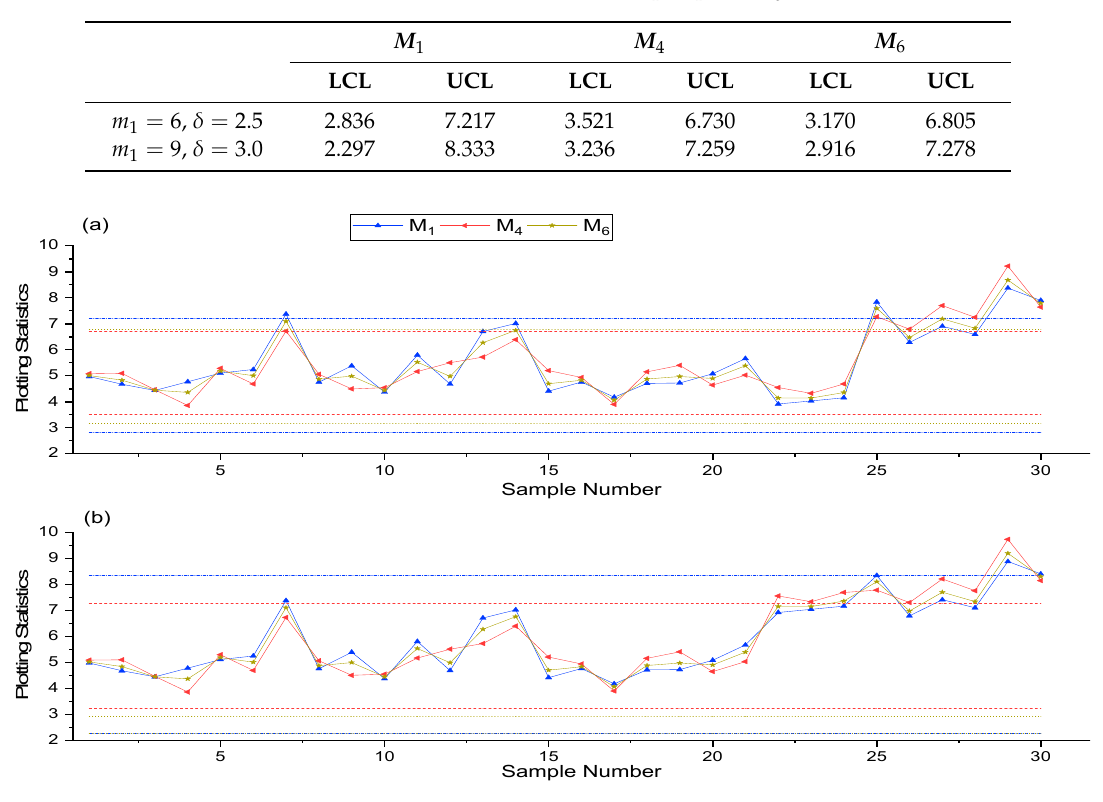
Figure 9. Graphical displays of plotting statistics corresponding to their control limits at ( a ) 𝑚 = 6 and 𝛿 = 2.5 ; ( b ) 𝑚 (cid:2869)